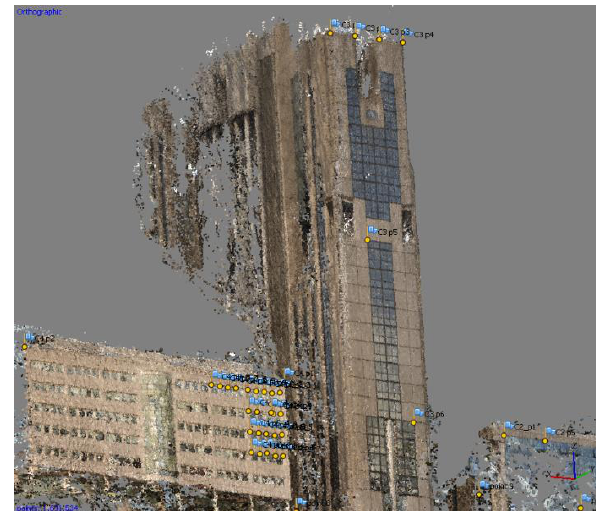
Figure 1. Raw dense 3D point cloud obtained from the post- processing of the photogrammetric survey. Blue flags are the GCPs used in